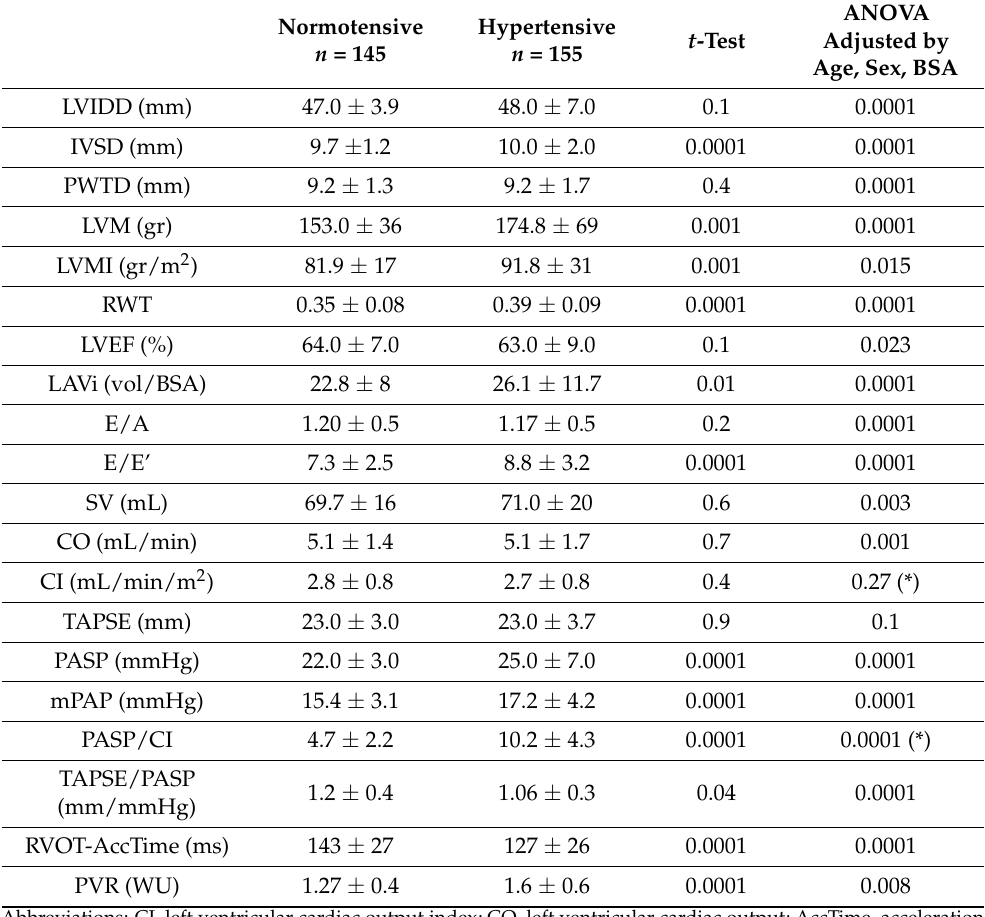
Table 2. Baseline echocardiographic variables in normotensive and hypertensive subjects. Normotensive n =